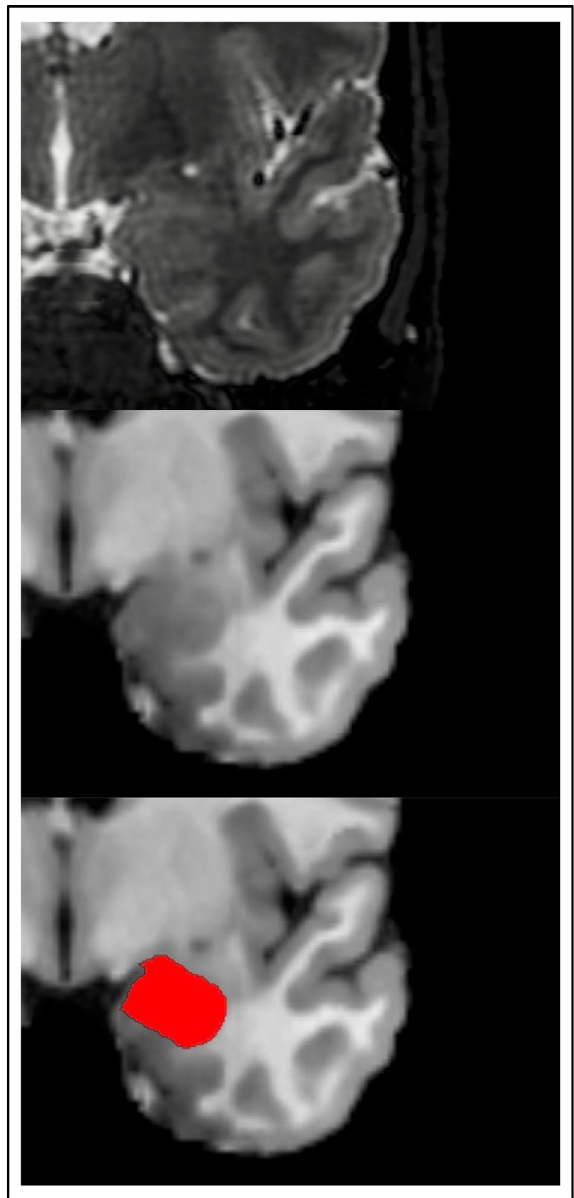
Figure 1. Segmentation of the amygdala. T2-weighted and T1-weighted images of the amygdala as segmented by